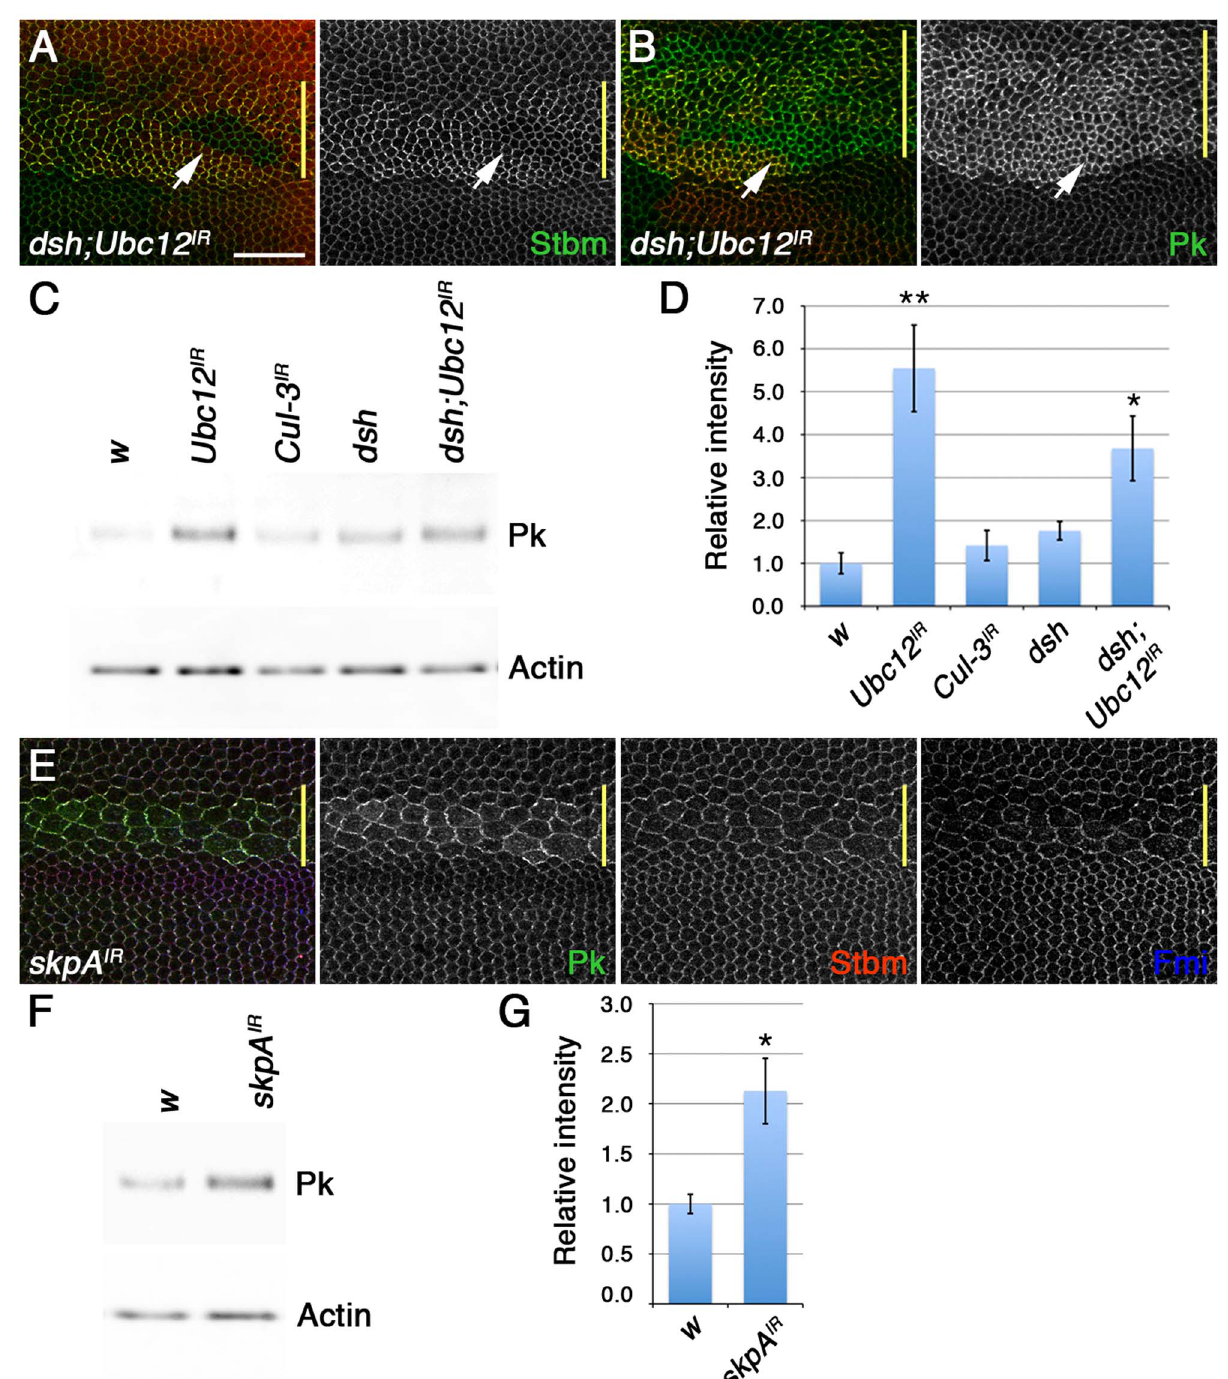
Figure 7. The SkpA ubiquitin ligase subunit regulates Pk degradation. (A,B) dsh V26 clones, marked by loss of Dsh staining (red), in wings expressing ptc-GAL4/ + ; Ubc12 IR-7375R-3 / + , stained for Stbm (green in A) or Pk (green in B). Note that Pk still accumulates at high levels at junctions when Ubc12 RNAi is expressed in dsh V26 clones, but Stbm does not (arrows). Yellow bar marks the ptc-GAL4 domain. Scale bar 20 m m. (C,D) Western blot (C) and quantitation (D) of Pk levels relative to Actin levels, in 28 hr pupal wing extracts from w 1118 , MS1096-GAL4; Ubc12 IR-7375R-3 / + , MS1096-GAL4; Cul3 IR-109415 / + , dsh 1 and dsh 1 MS1096-GAL4; Ubc12 IR-7375R-3 male flies. Quantitation from 3 biological replicates. p* , 0.05, p** , 0.01. (E) Pk (green), Stbm (red) and Fmi (blue) staining of wings expressing ptc-GAL4/skpA IR-46605 . Note that whilst the increase in Pk levels in wings expressing Ubc12 RNAi may contribute to clustering of the other core proteins, the increase in Pk in wings expressing low levels of skpA RNAi is insufficient to do this. (F,G) Western blot (F) and quantitation (G) of Pk levels relative to Actin levels, in 28 hr pupal wing extracts from w 1118 and MS1096-GAL4/ + ; skpA IR-46605 / + female flies. Quantitation from 3 biological replicates, error bars are s.e.m,. p* , 0.05.